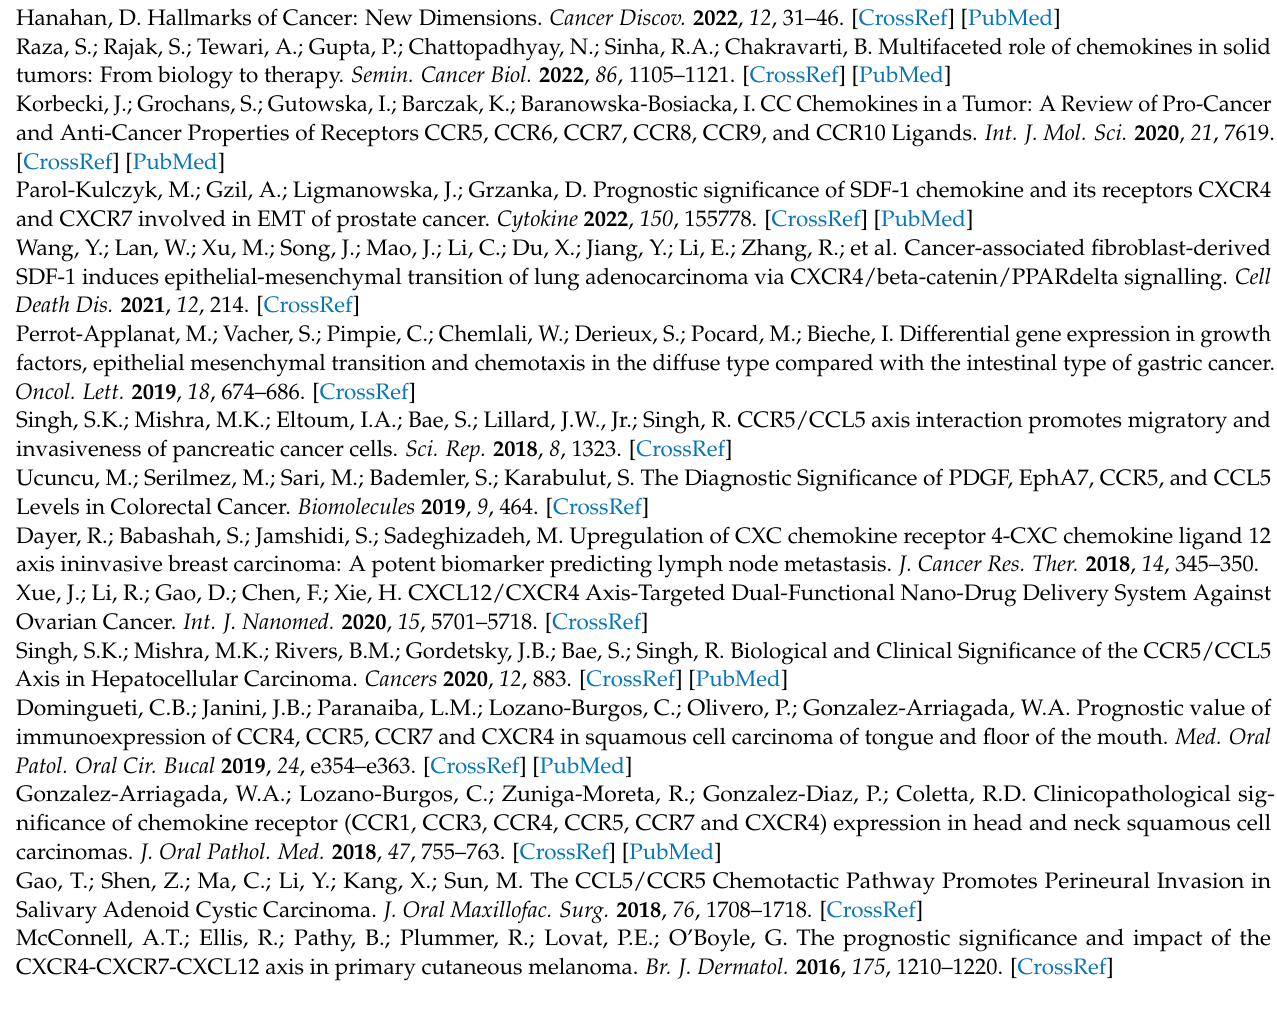
Table S2: Description of clinical